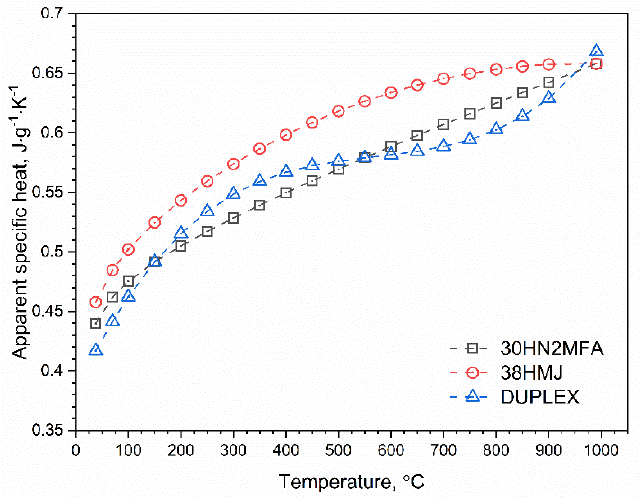
The experimental specific heat data are presented in Table 3 and illustrated in Figure 4. Data between points were approximated in COMSOL using cubic splines.